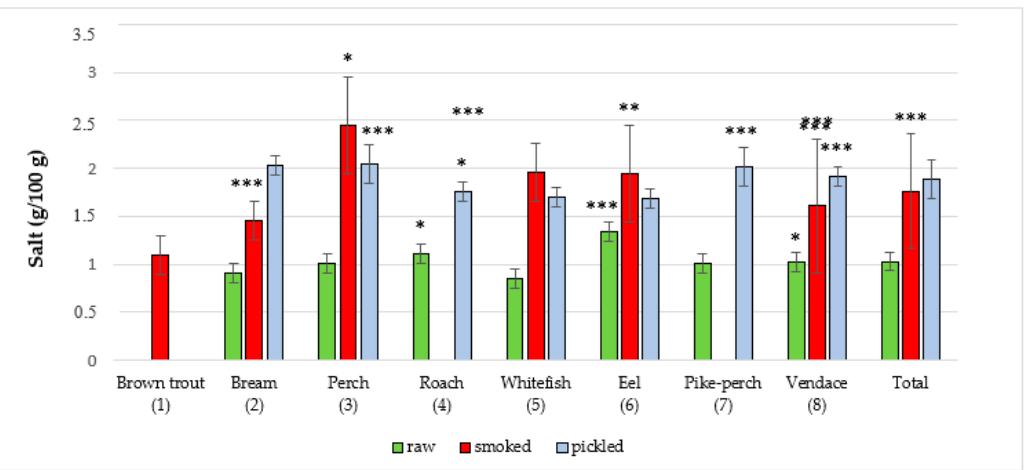
Figure 3. Salt content in raw ( R ), smoked ( S ) and pickled ( P ) fish products samples (g / 100 g). The statistical analysis has shown significant differences of content of salt between species in R, S and P groups of freshwater fish products (*** p < 0.001, ** p < 0.01, * p < 0.05). R : p < 0.05, (3 vs. 2, 5), (4 vs. 2, 5, 7) and (8 vs. 2, 5); p < 0.001, (6 vs. 2, 3, 4, 5, 7, 8); S: p < 0.01, (3 vs. 1, 2, 5, 6, 7, 8); p < 0.01, (6 vs. 1, 2), p < 0.001, (2 vs. 1), (5 vs. 1, 2) and (8 vs. 1); P: p < 0.05, (2 vs. 4, 5, 6, 8); p < 0.01, (4 vs. 6); p < 0.001, (3 vs. 4, 5, 6), (7 vs. 4, 5, 6) and (8 vs. 4, 5, 6); Total : p < 0.001, (P vs. R) and (S vs. R).